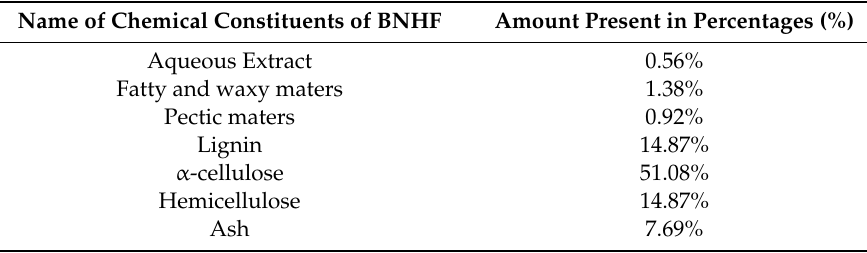
Table 1. Main chemical constituents of BNHF.